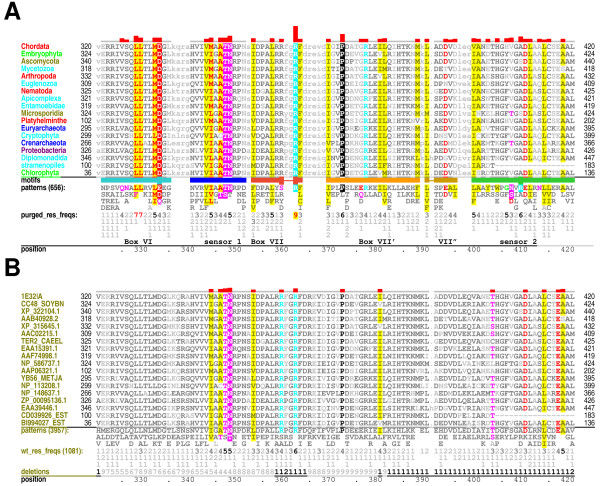
CHAIN analysis of the D1 AAA+ module of p97 ATPases. See legends to Figs 4 and 5 for descriptions and text for discussion. (A) Motif-based contrast hierarchical alignment. The bars directly below the aligned sequences indicate motif regions; wide bars indicate residues shown in Fig. 7 and discussed in the text. (B) PSI-BLAST generated contrast hierarchical alignment.